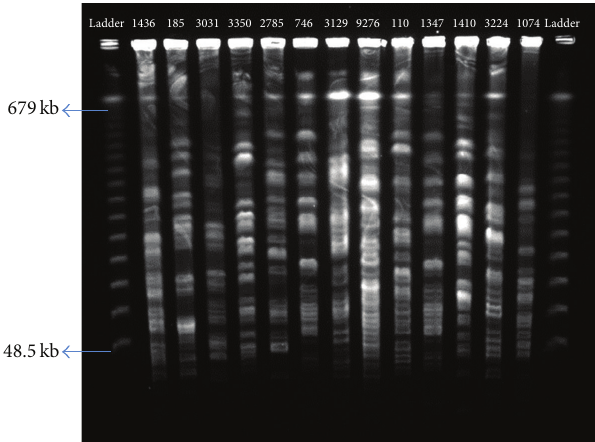
Figure 2: CHEF profiles of UPEC strains isolated. Lateral lanes contain Lambda Ladder PFG Marker. Size range: 48.5 kb to 679 kb (14